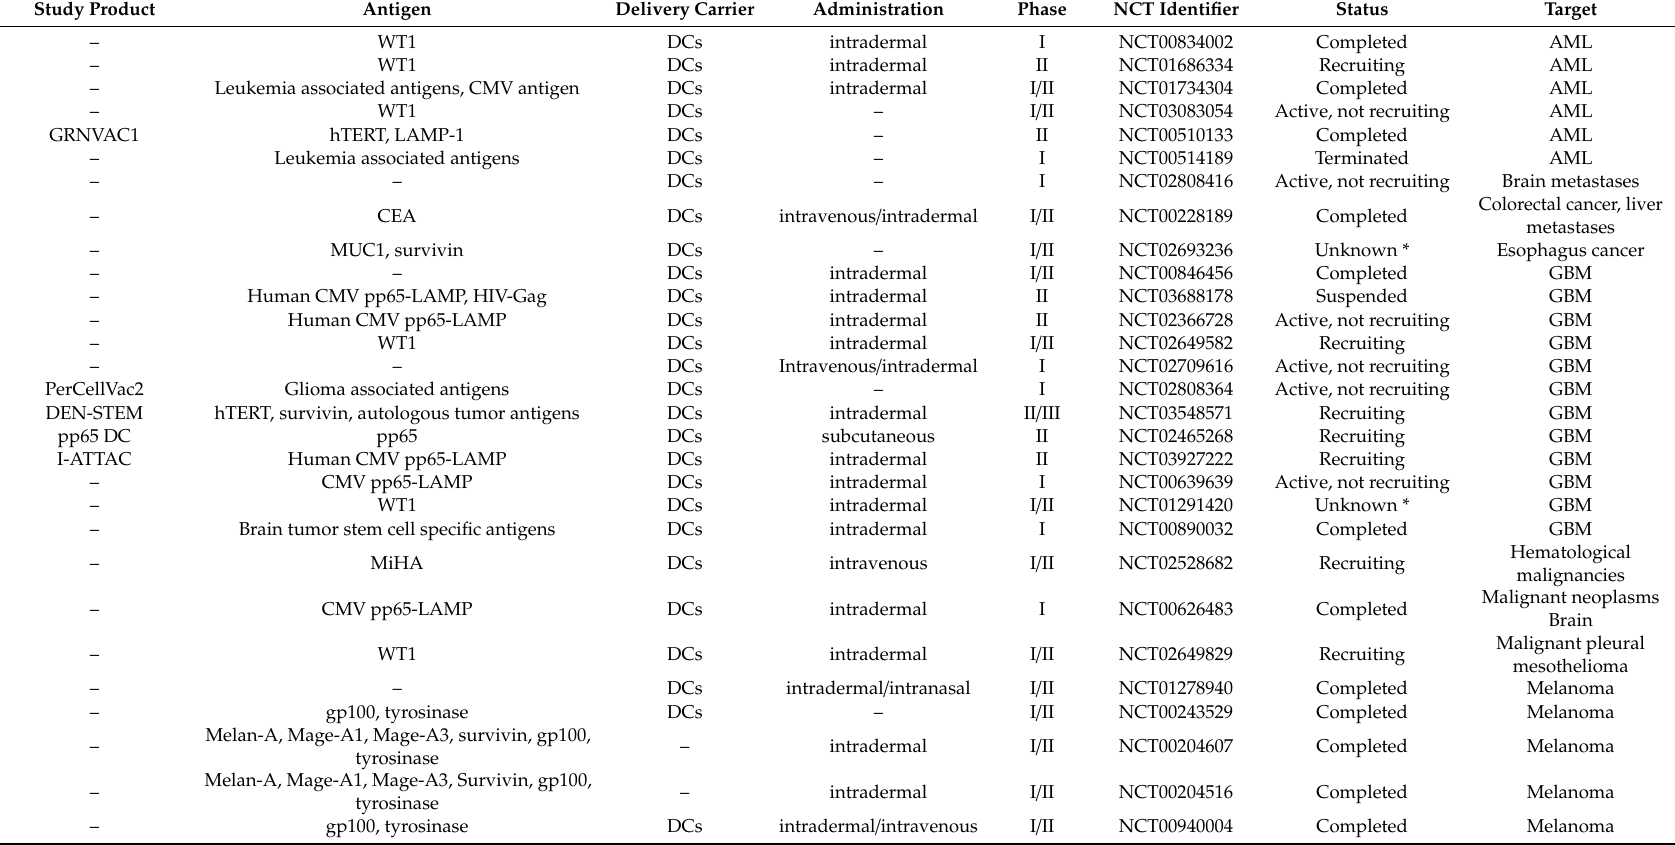
Table 3. Examples of mRNA vaccine clinical trials for